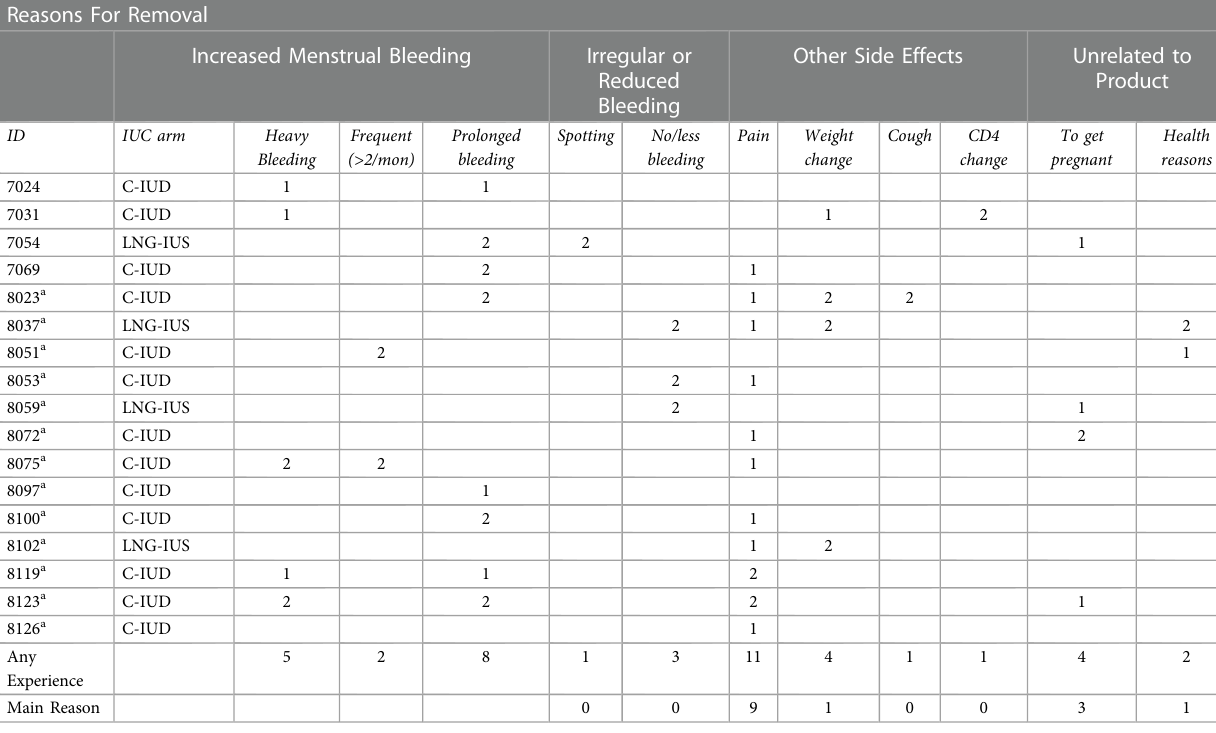
TABLE 2 Matrix for dominant and all discontinuation reasons among women living with HIV participating in a clinical trial in Cape Town, South Africa ( n =17). Reasons For